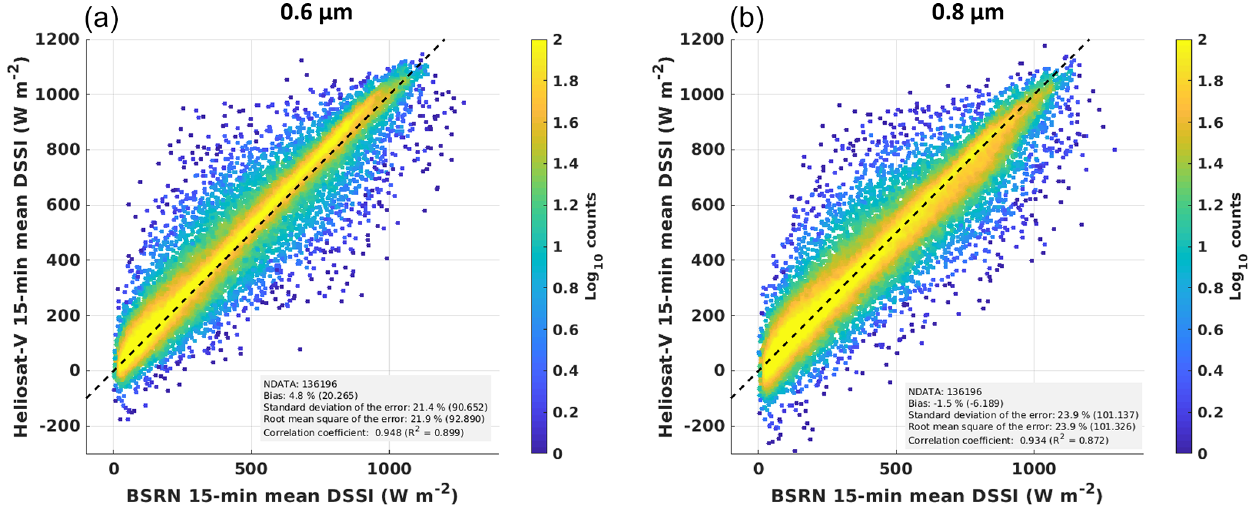
Figure 11. Two-dimensional histograms of satellite-based DSSI estimates from the Heliosat-V method versus ground-based BSRN measure- ments for the MSG 0.6µm channel (a) and 0.8µm channel (b)